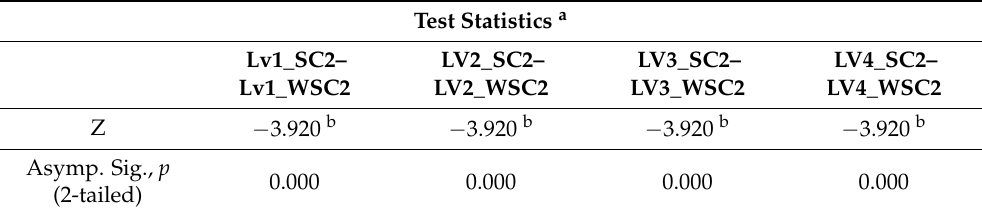
Table 8. The results of the Wilcoxon signed-rank test reveal a significant relationship between the performance of SC and non-SC scenarios.